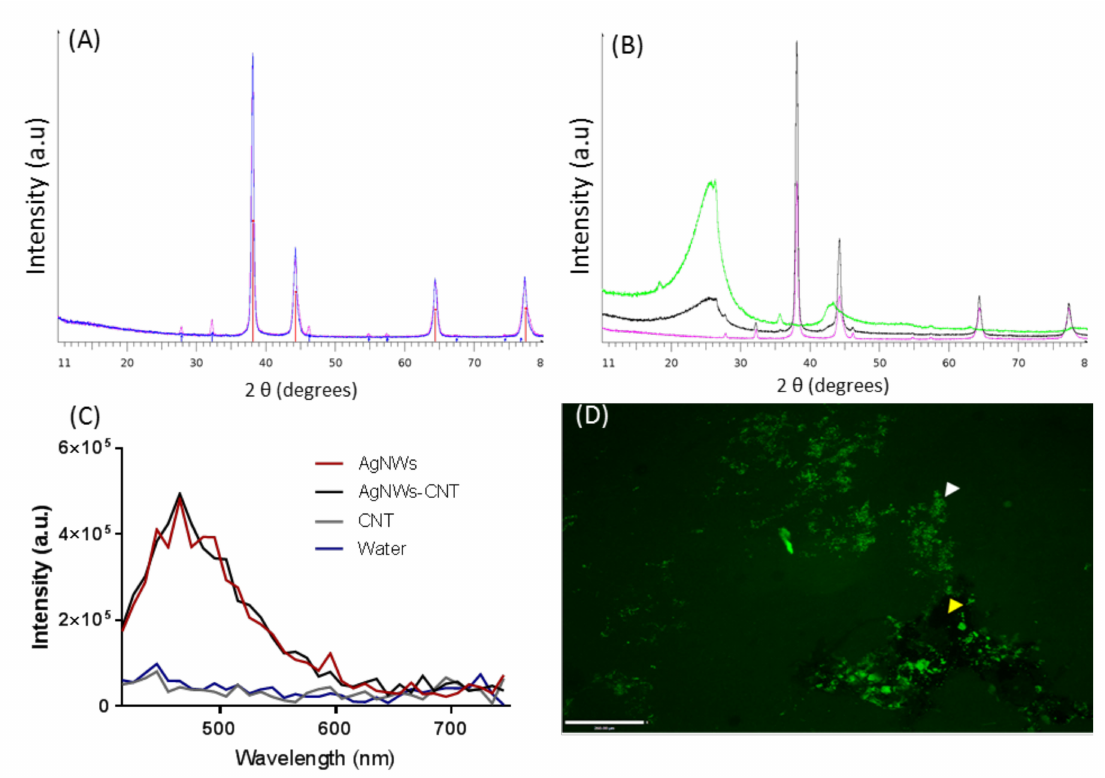
Figure 2. XRD pattern and fluorescence spectra. ( A ) XRD pattern of AgNWs (pink) and AgNWs-CNT (blue); red bars: Ag, PDF No. 04-0783; blue bars: AgCl, PDF n. 31-1238. ( B ) XRD pattern of AgNWs (violet), AgNWs-CNT-mix (black) and CNTs (green). ( C ) The emission fluorescence peaks of AgNWs (red), AgNWs-CNT-mix (black), CNTs (grey) and water (blue). ( D ) Fluorescence microscope image of AgNWs-CNT in water; the white arrow indicates AgNWs, and the yellow arrow indicates CNTs (scale bar 200 µ